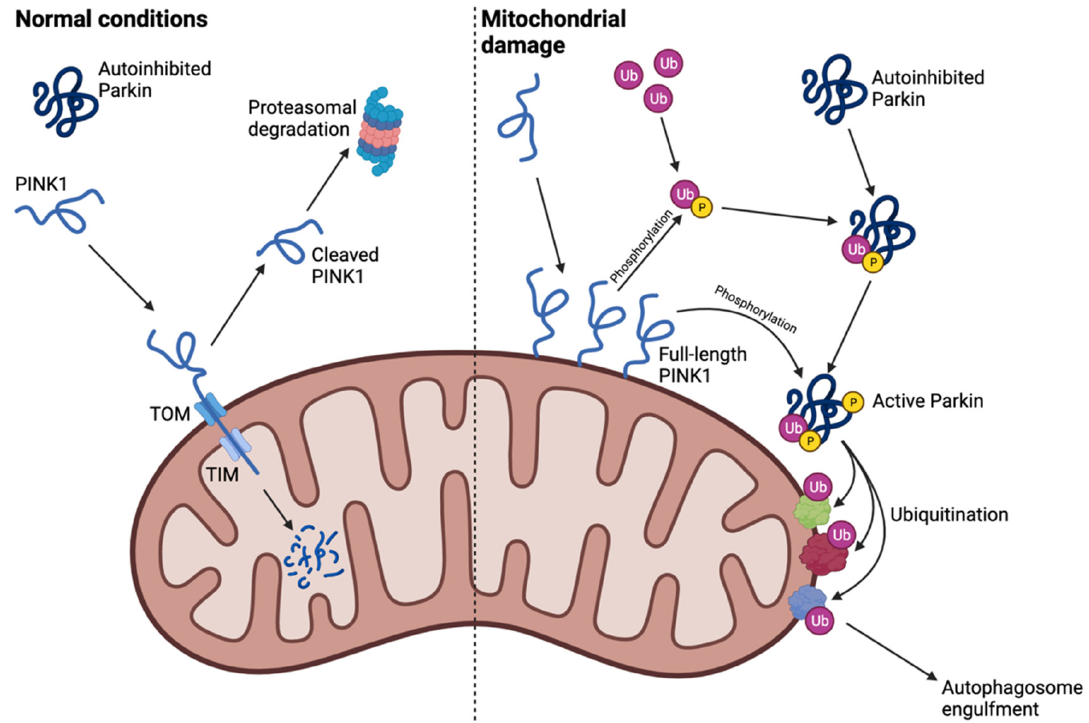
Figure 3. Visualization of mitophagy. Left side: during normal conditions, PINK1 is continuously transported across the mitochondrial membrane through the translocase of inner membrane (TIM) and translocase of outer membrane (TOM), during which cleavage of PINK1 takes place. This results in the formation of a shorter, cleaved form of PINK1 that is targeted for degradation by the proteasome. Low levels of PINK1 are then present at basal conditions, and Parkin is present in its autoinhibited form. Right side: due to mitochondrial damage or mitochondrial depolarization, the cleavage of PINK1 does not occur, leading to its accumulation on the mitochondrial membrane. Accumulated PINK1 can then phosphorylate free ubiquitin, which can bind to Parkin and, along with PINK1-mediated phosphorylation, activate and translocate Parkin to the mitochondria. Here, Parkin can perform ubiquitination reactions on mitochondrial outer membrane proteins, leading to the engulfment of the mitochondria by autophagosomes and subsequent lysosomal degradation. Created using www.BioRender.com (accessed on 10 December